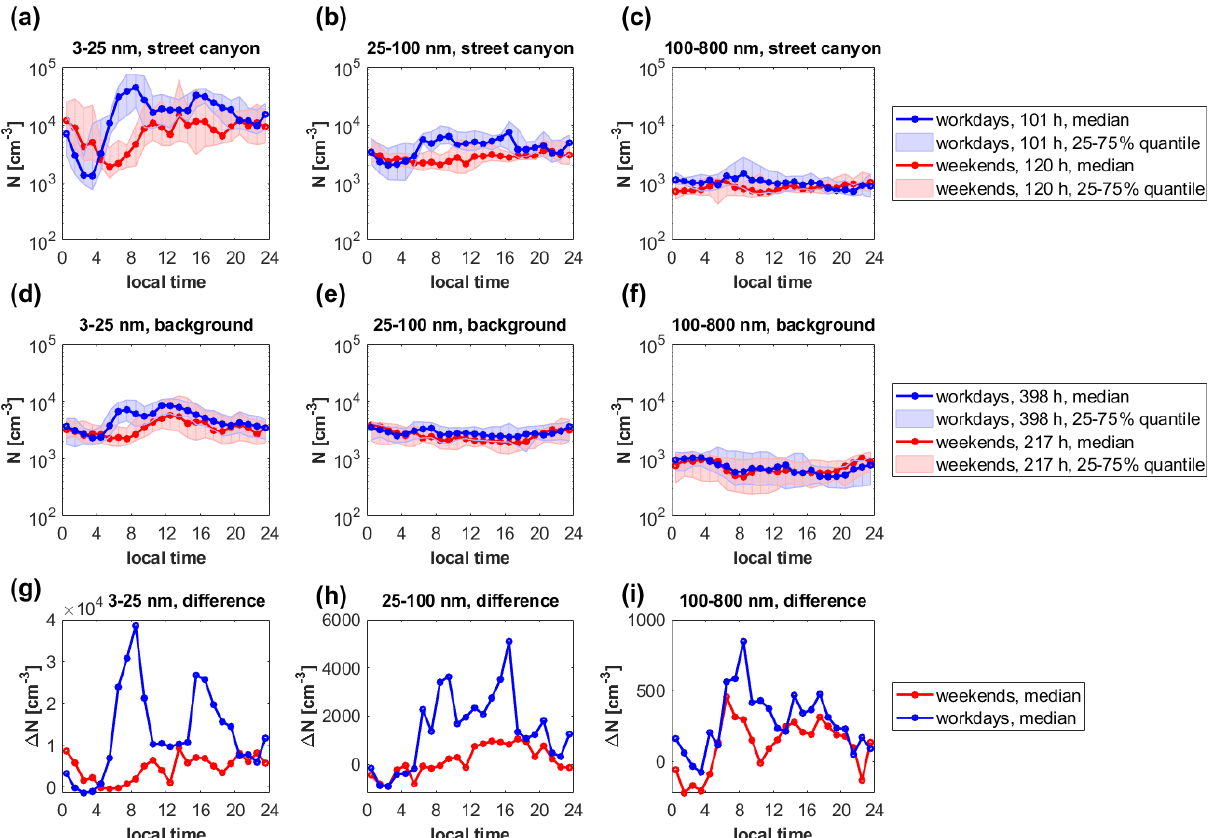
Figure 4. Diurnal variations of nucleation (3–25nm), Aitken (25–100nm), and accumulation (100–800nm) mode particle concentrations during weekends (red) and workdays (blue) measured at the street canyon (a–c) and background station (d–f) as well as the difference between the street canyon site and the background station concentrations (g–i) . The median diurnal variations are shown as solid lines with markers; the 25th and 75th percentile ranges are presented as shaded areas. This figure with a linear y axis can be found in Fig.